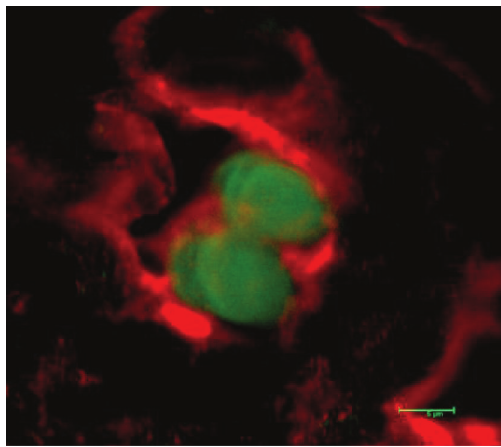
Figure 2: Skin sample from long-term WF-ACI VCA acceptor ani- mals stained for CD4 (red) cell surface staining and FoxP3 (green) intracellular staining. The merged image shows CD4 + /FoxP3 +